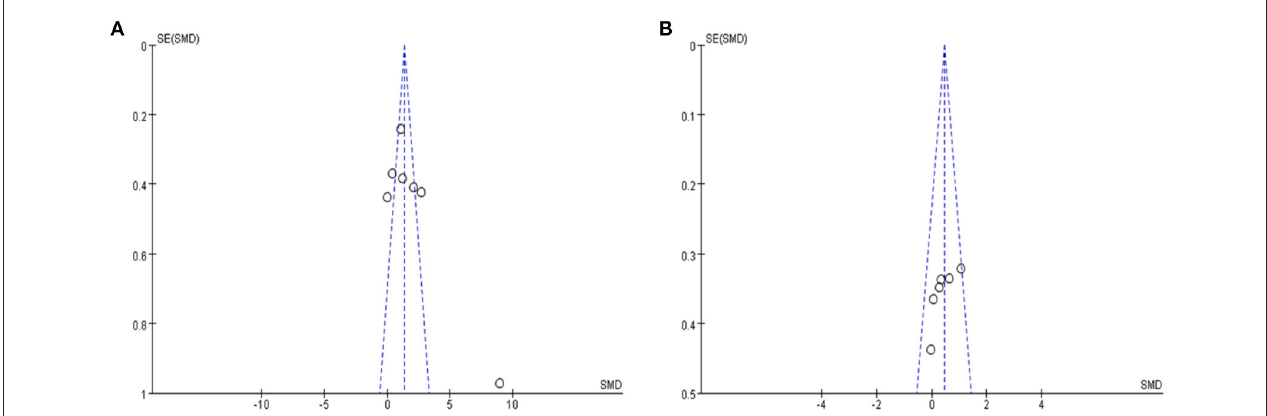
FIGURE 3 | (A) Funnel plot for the publication bias of global cognitive function (B) Funnel plot for the publication bias of memory. SMD, standardized mean difference.